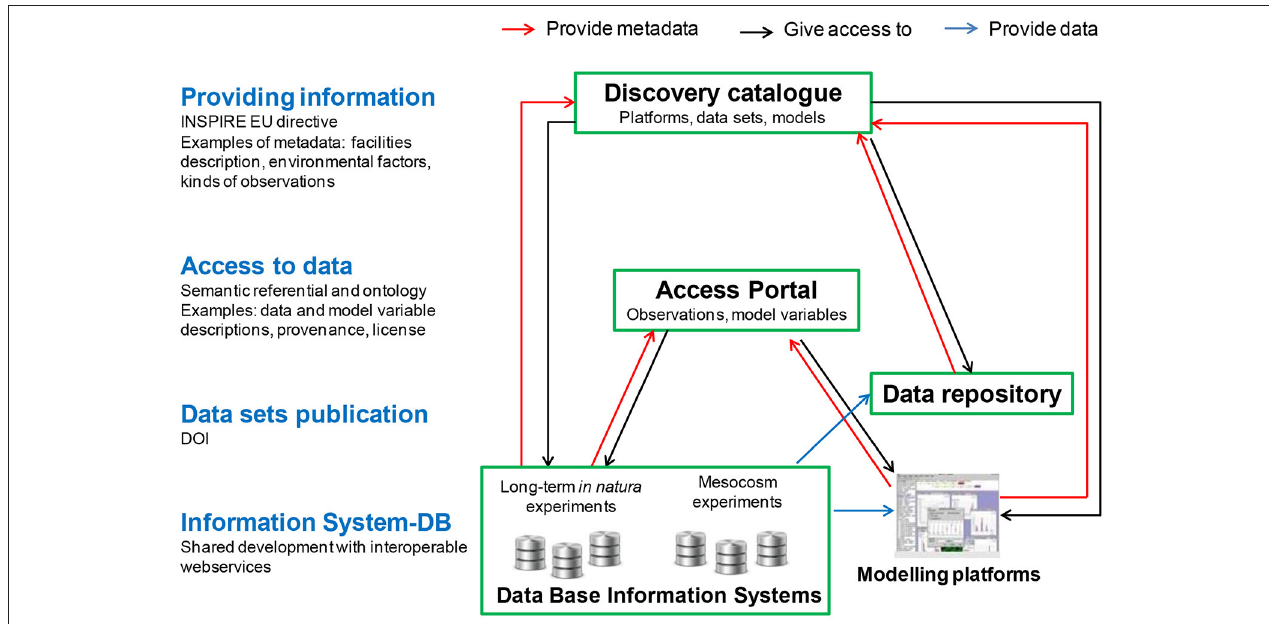
FIGURE 5 | The distributed architecture of the AnaEE-F information system includes a discovery catalog to access metadata information about platforms, datasets, or models, a portal to access metadata about observations or model variables including a semantic referential and an ontology, and a data repository to store digital object identifies (DOI) of data sets from information systems of in natura and mesocosm experiments. Data sets from experiments are linked with model factories to enable model parameterisation or data